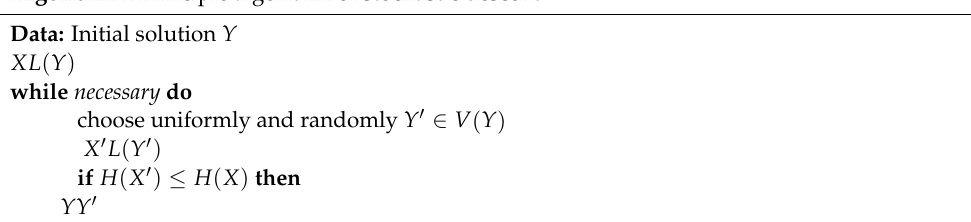
Algorithm 2 Principle algorithm of stochastic descent